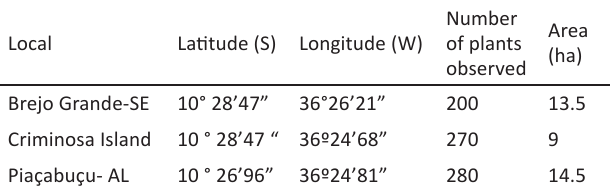
Table 1 – Geographical location of sample areas in the region of the mouth of São Francisco river.